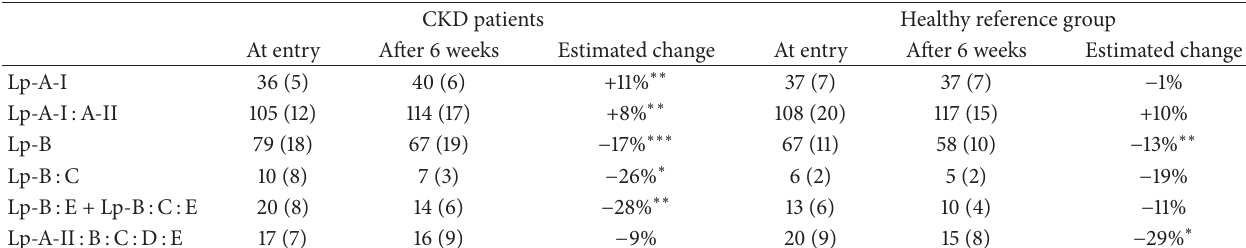
Table 4: Plasma concentrations of lipoprotein subclasses (mg/dL) in patients with chronic renal insufficiency ( n = 23) and healthy reference subjects ( n = 17) at start and end of treatment with 1mg tesaglitazar o.d. Mean and standard (in